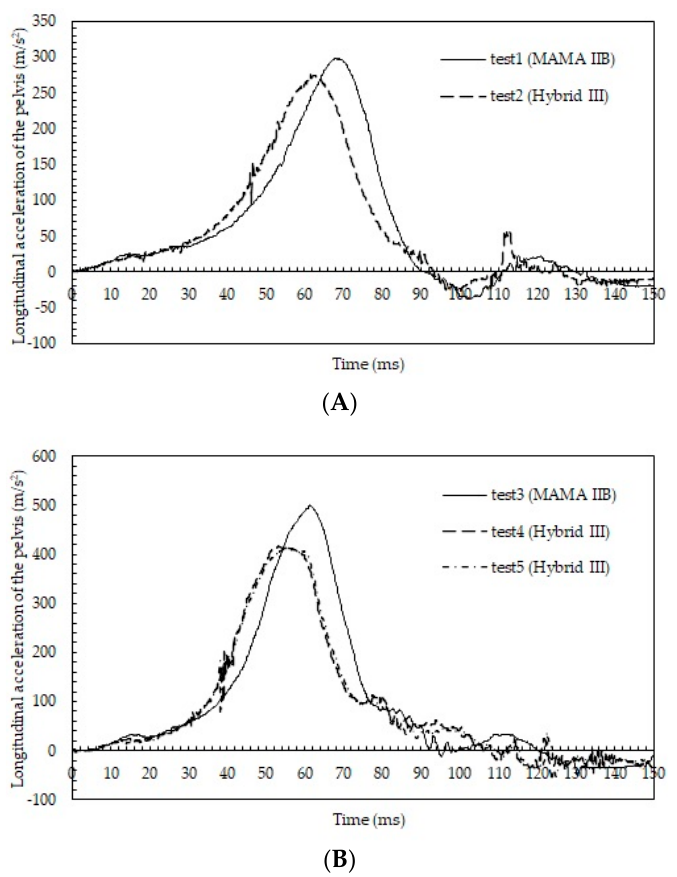
Figure 3. ( A )Time courses of the longitudinal accelerations of the pelvis in tests 1 and 2; ( B ) time courses of the longitudinal accelerations of the pelvis in tests 3–5.